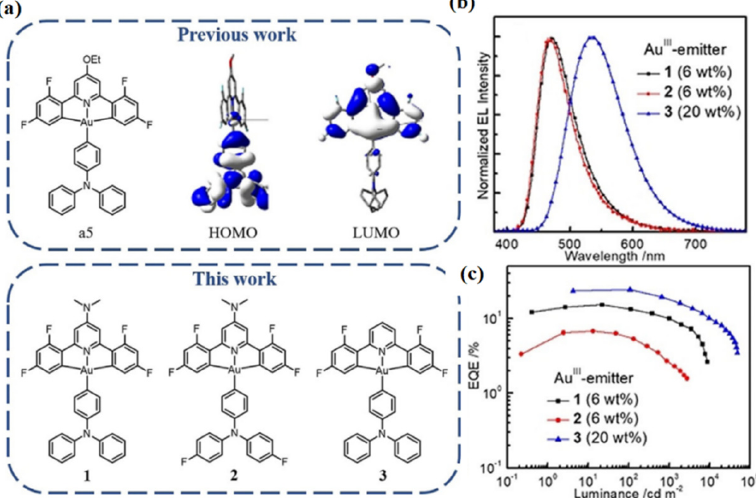
Figure 9. ( a ) Top: previously reported arylgold(III)-TADF complex a5 and its HOMO and LUMO surfaces. Bottom: donor–acceptor type C^N^C gold(III) complexes Au(III)-1–Au(III)-3 in this work; ( b ) normalized EL spectra; and ( c ) EQE–luminance characteristics of OLEDs based on Au(III)-1, Au(III)-2, and Au(III)-3 at their optimized doping concentration. Reproduced with permission from Dongling Zhou, Gang Cheng, Glenna So Ming Tong et al., “High Efficiency Sky-Blue Gold(III)-TADF Emitters”; published by John Wiley and Sons , 2020 [72].